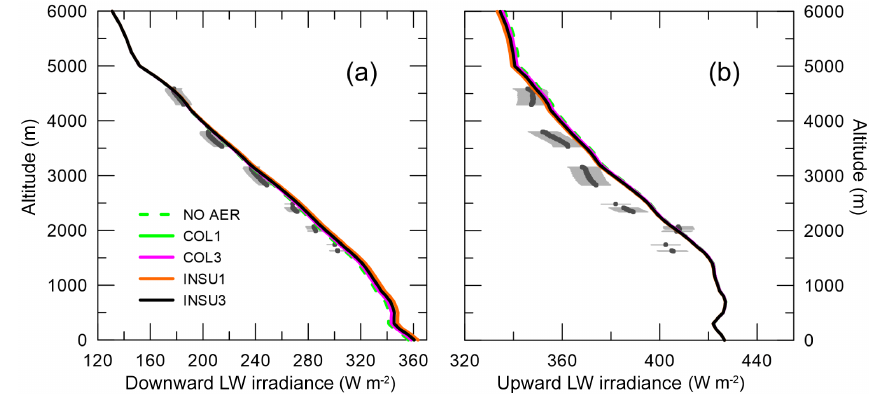
Figure 10. Same as Fig. 6, but for profile